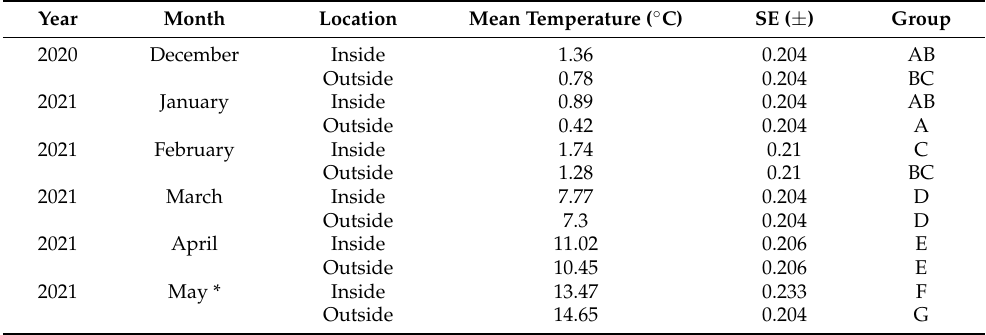
a Represents the dates when photosynthesis, stomatal conductance, and transpiration were measured on treat- ment branches. Table 3. Mean (+/ − SE) temperatures inside and outside mesh cages from December 2020 to May 2021. Cages were removed after May. Group represents letters indicating statistical differences between mean temperatures determined by Tukey’s HSD test. Different letters for outside and inside temperatures within a month indicate statistical significance ( p <